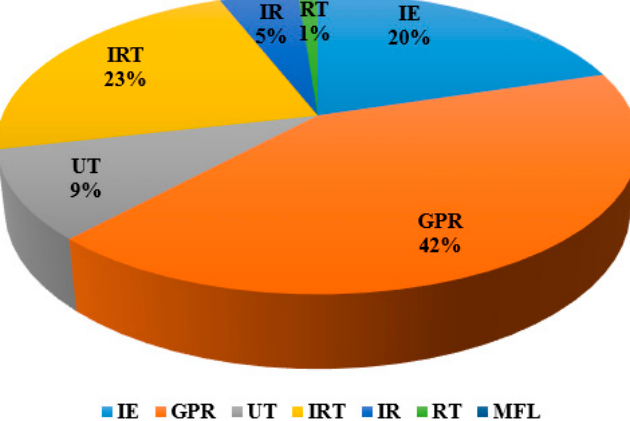
Figure 6. Statistical representation of NDT methods most applicable to detect delamination.